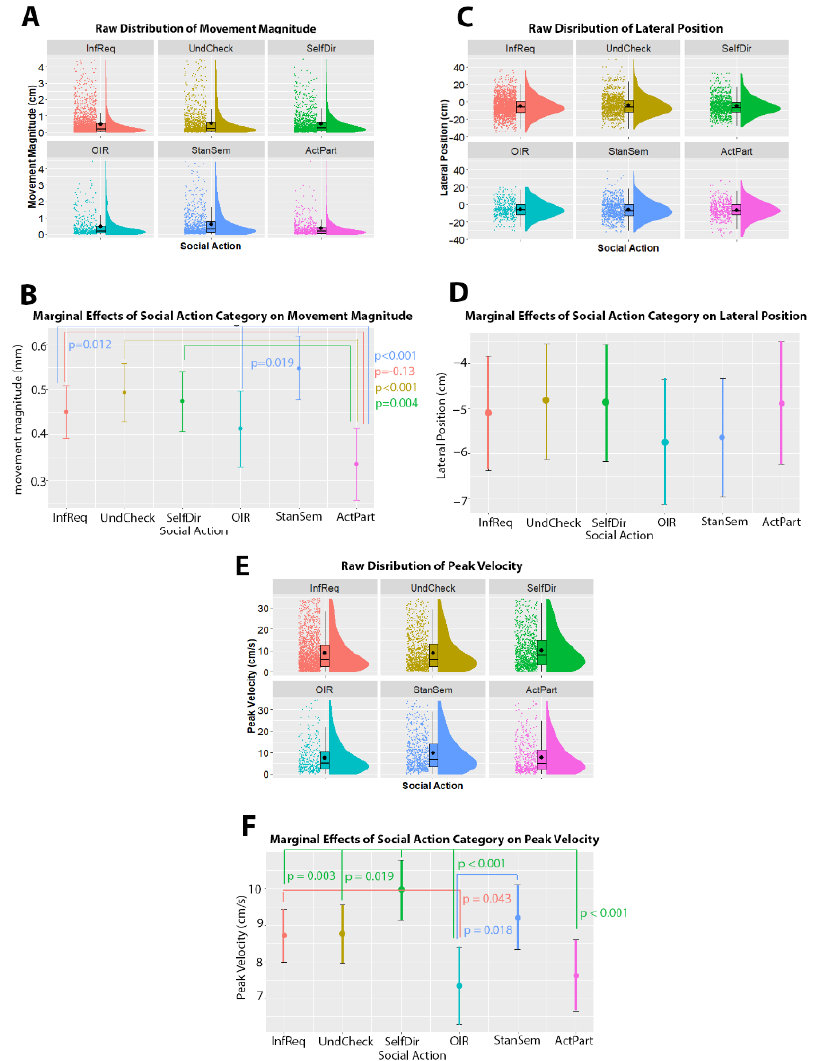
Figure 2. Relationship between torso movement and social action category. Panels ( A , C , E ) show raincloud plots of the raw distribution ( y -axis) across each of the social action categories ( x -axis). The raincloud plots show the overall density of the distribution (shaded curve), the boxplots show the median and interquartile range, while the black dots show the individual data points. Panels ( B , D , F ) depicts the marginal effects of the mixed model (i.e., the predicted values when holding other model terms, such as utterance duration and per-participant intercepts, constant). In panels ( B , D , F ) social action categories are given on the x -axis, and kinematic values are given on the y -axis. Significant differences between pairs of categories are indicated with colored lines between the categories. p -values are given for each of these comparisons, with the text color corresponding to the larger value in the comparison. Abbreviations: InfReq = Information Request; UndCheck = Under- standing Check; SelfDir = Self-Directed Question; OIR = Other-Initiated-Repair; StanSem = Stance or Sentiment; ActPart = Active